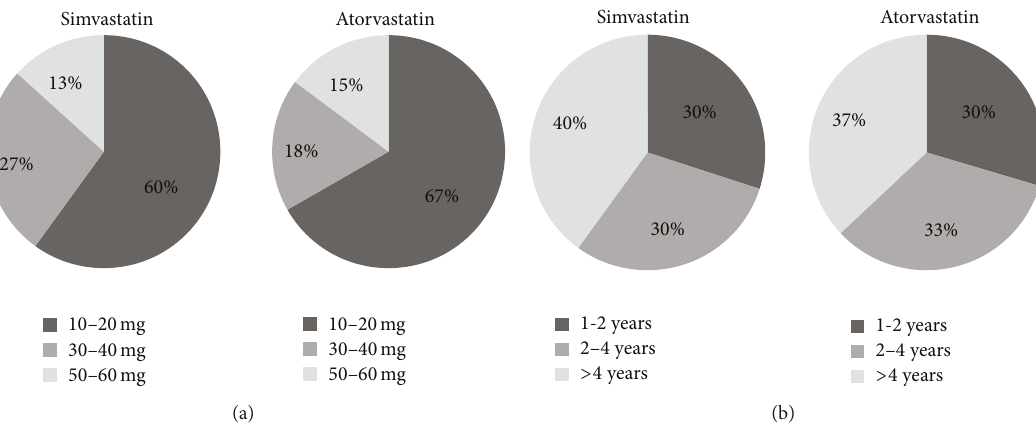
Figure 4: Distribution of study group participants on di ff erent doses and durations of use of statins.